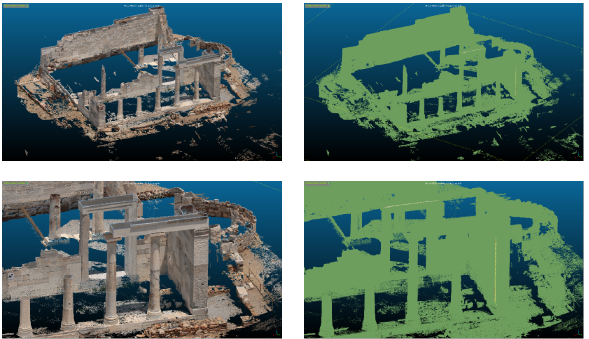
Figure 8. Semantically enriched dense 3D point cloud created using the Agisoft-Metashape software.